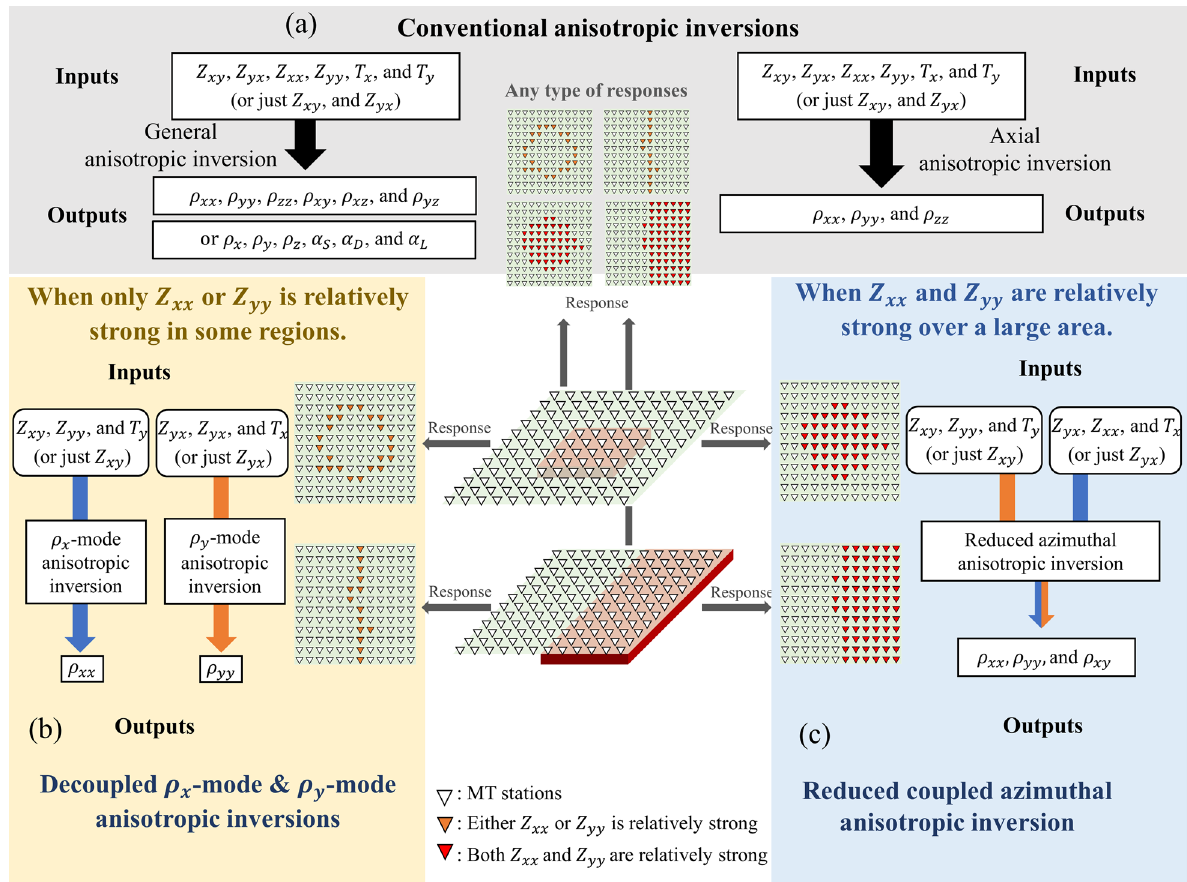
Fig. 13 A one‑page summary of a the conventional methods and our two new designed processes, b the decoupled ρ x − mode and ρ y − mode anisotropic inversion, and c the reduced coupled azimuthal anisotropic